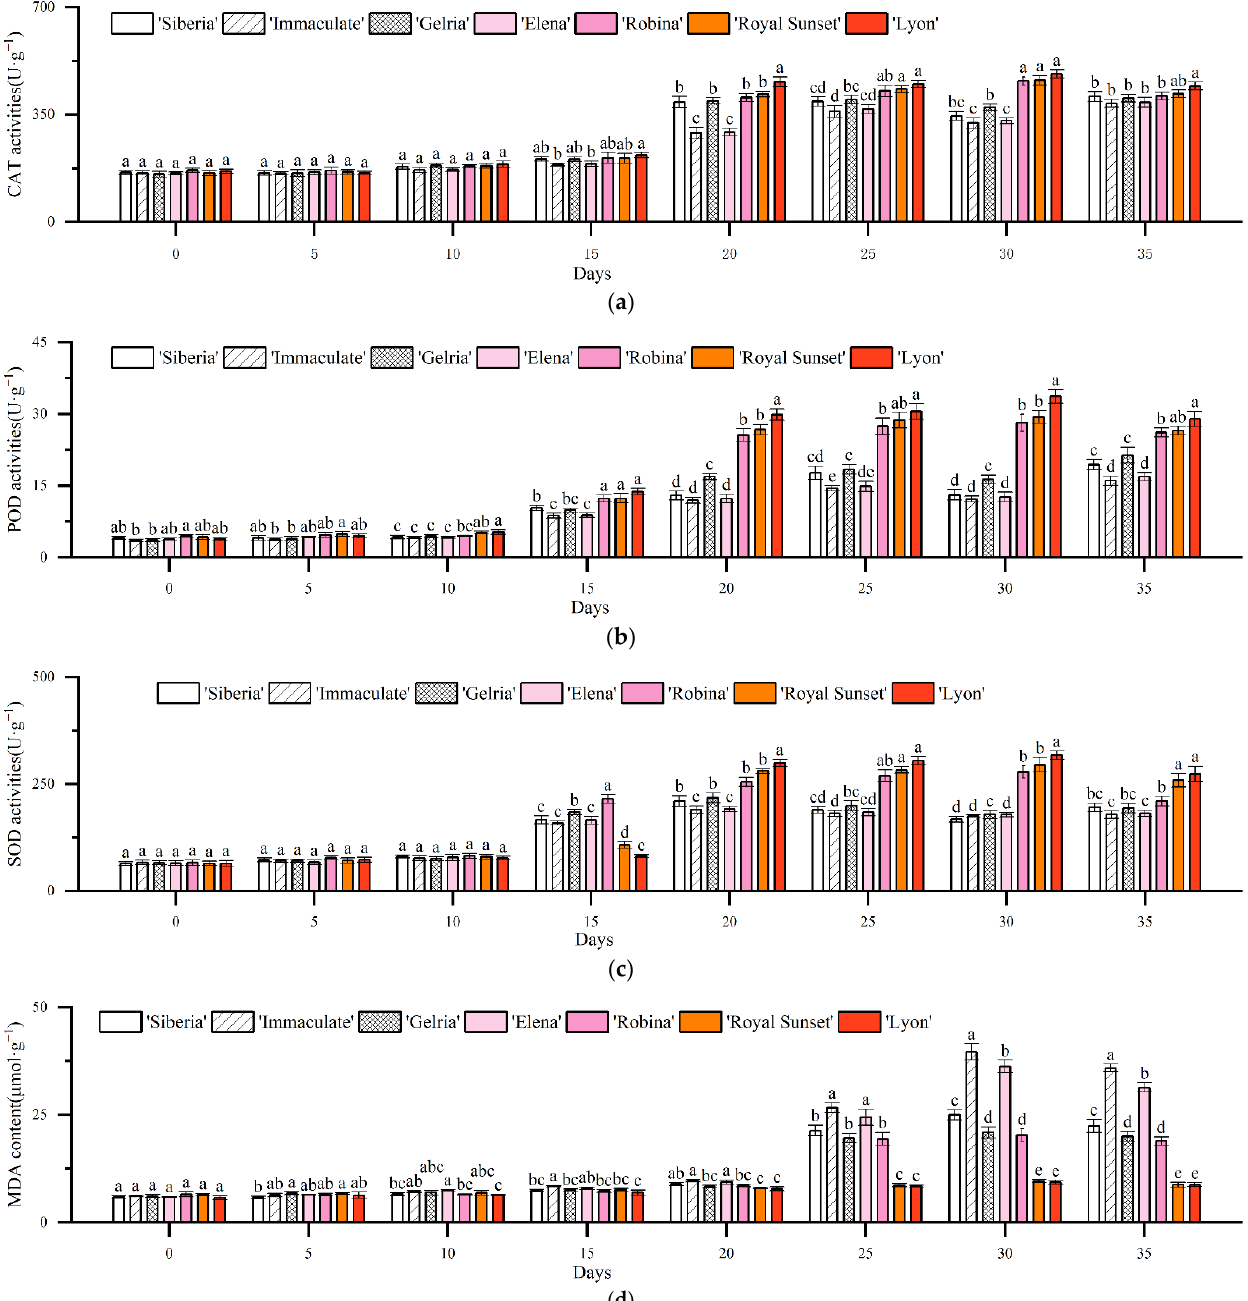
Figure 6. Effects of drought stress on antioxidant enzyme activity of lily leaves: ( a ) Effects of drought stress on CAT enzyme activity; ( b ) Effects of drought stress on POD enzyme activity; ( c ) Effects of drought stress on SOD enzyme activity; ( d ) Effects of drought stress on MDA content. Different letters above bar graphs indicate significant difference among lily varieties ( p < 0.05, n = 3).